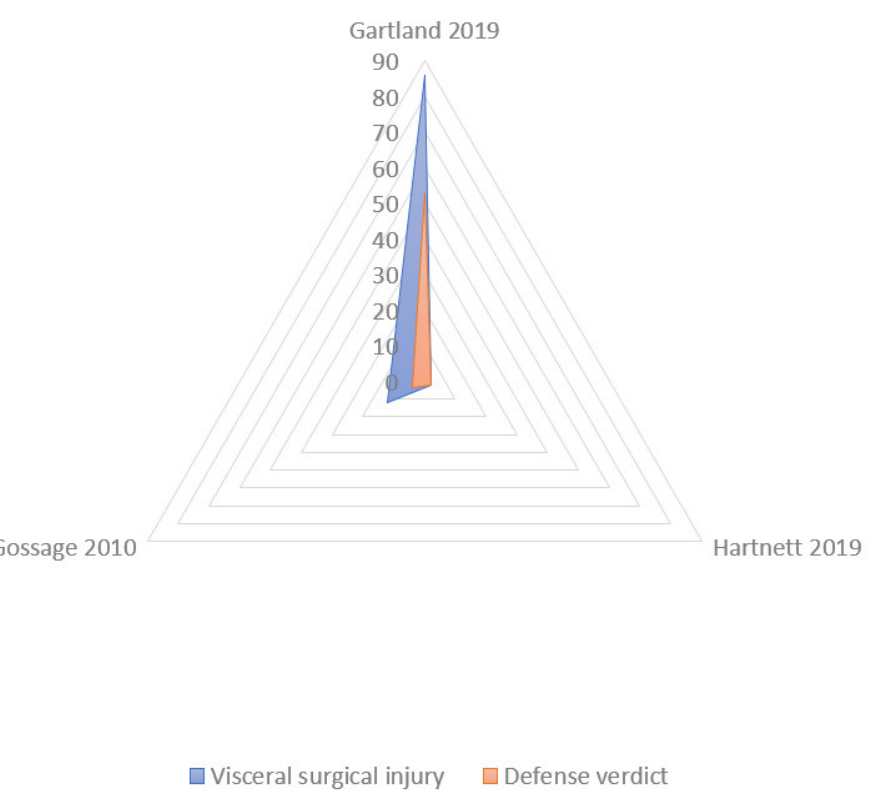
Figure 10. Radar chart: defensive verdicts in litigations for visceral damage. The largest polygon (blue area: visceral surgical injuries) is associated with a high rate of defensive verdicts in litigations (pink area).